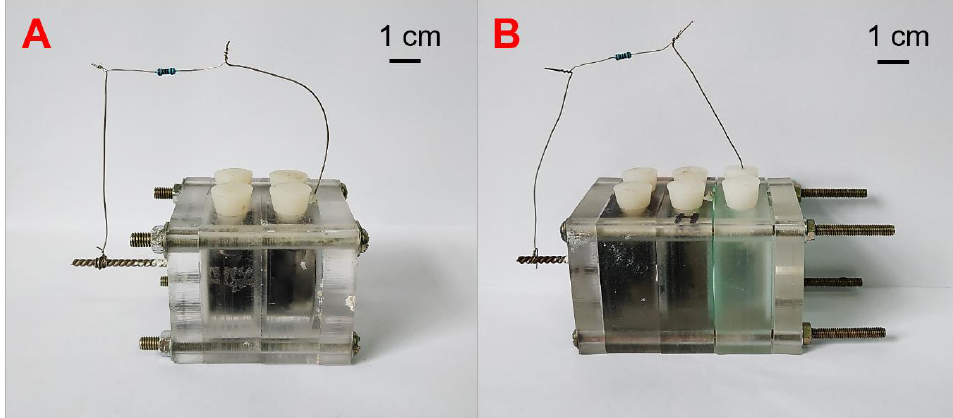
Figure 1. The single-chamber ( A ) and double-chamber ( B ) microbial fuel cell (MFC)